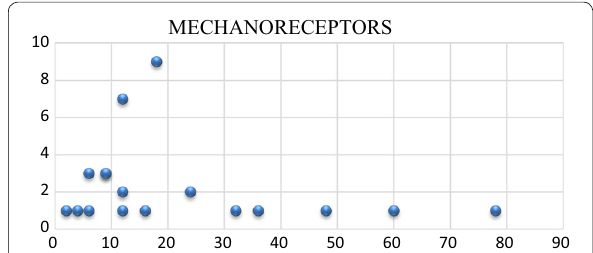
Fig. 1 Scatter plot showing distribution of number of mechanoreceptors ( X -axis) versus duration in months ( Y -axis). There was no significant correlation between total number of mechanoreceptors and interval from injury to operation